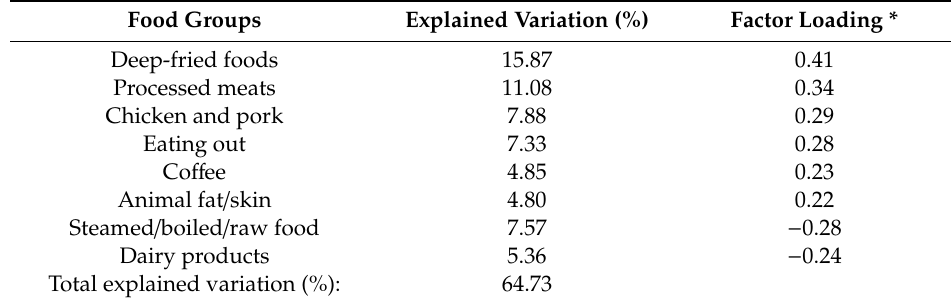
Table 4. Food groups that were strongly associated with the dysregulated iron metabolism-related dietary pattern scores identified using a reduced rank regression (RRR).